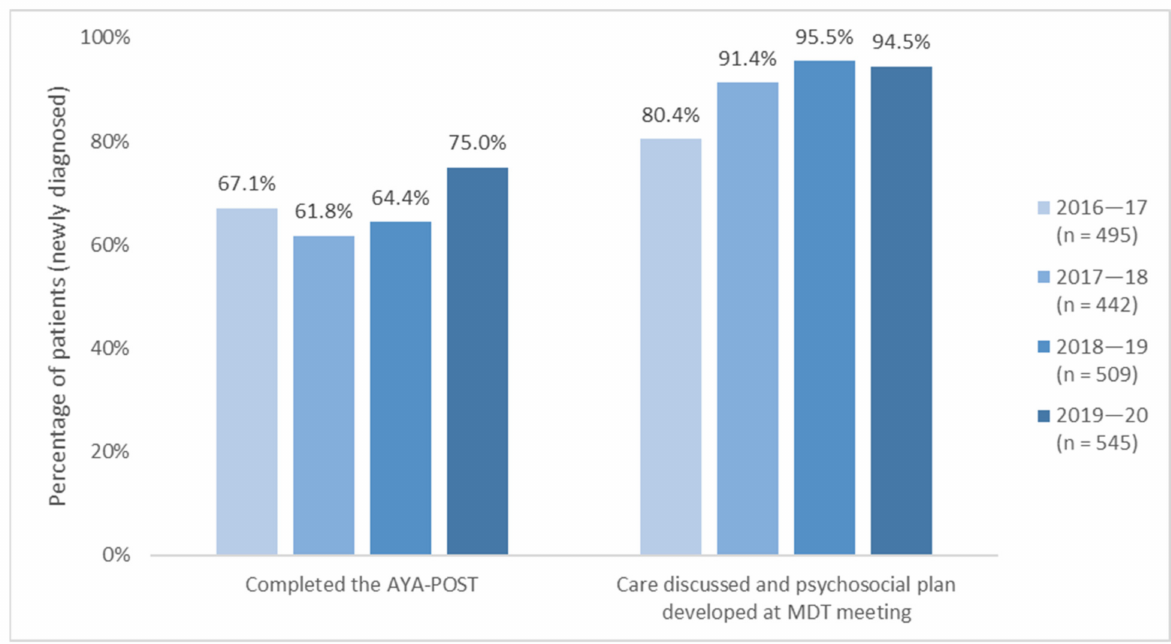
Figure 3. YCS activity data on psychosocial care, 2016–17 to